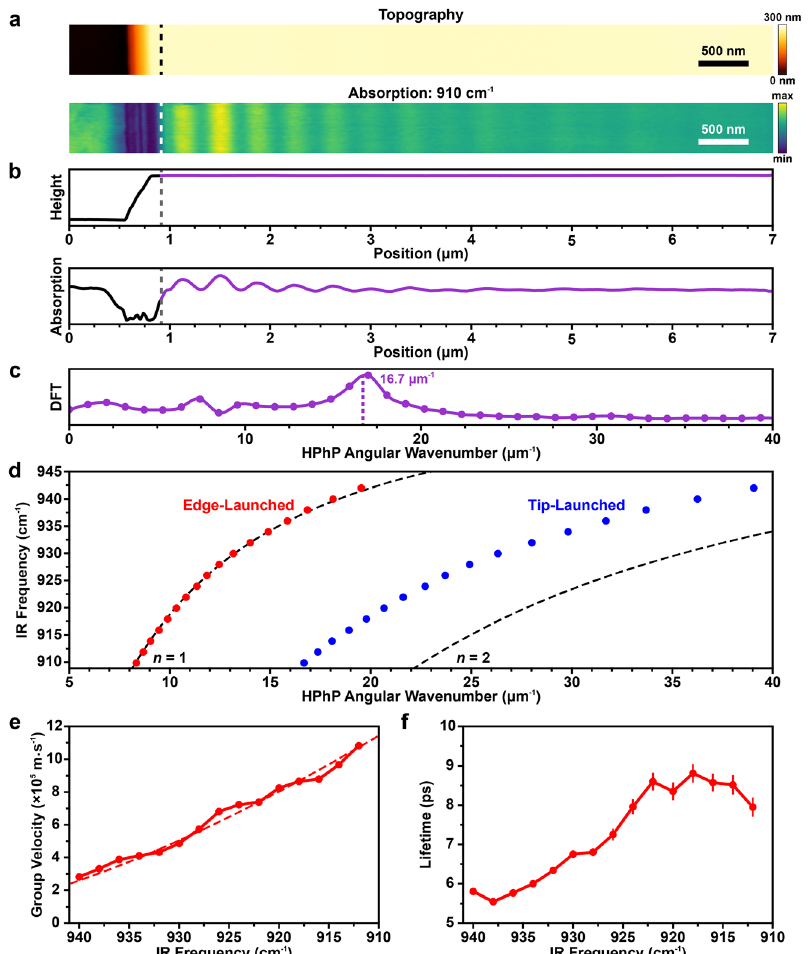
prominent polariton peak ( ≈ 16.7 µm − 1 ). By plotting the angular wavenumbers of the detected DFT peaks (blue cir- series of PTIRimages, measuredat different IRwavelengths,